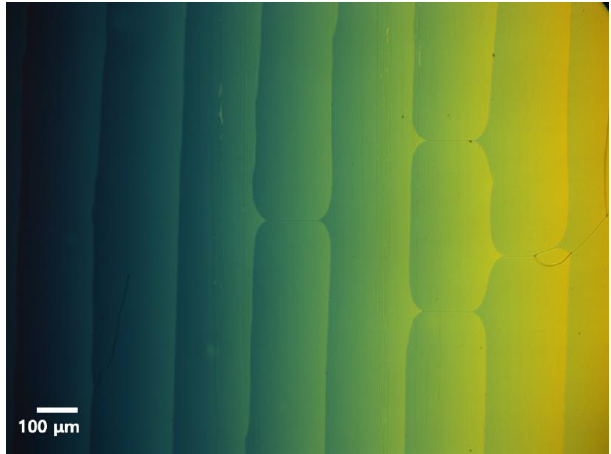
Figure 3. Photograph of the CLC texture.